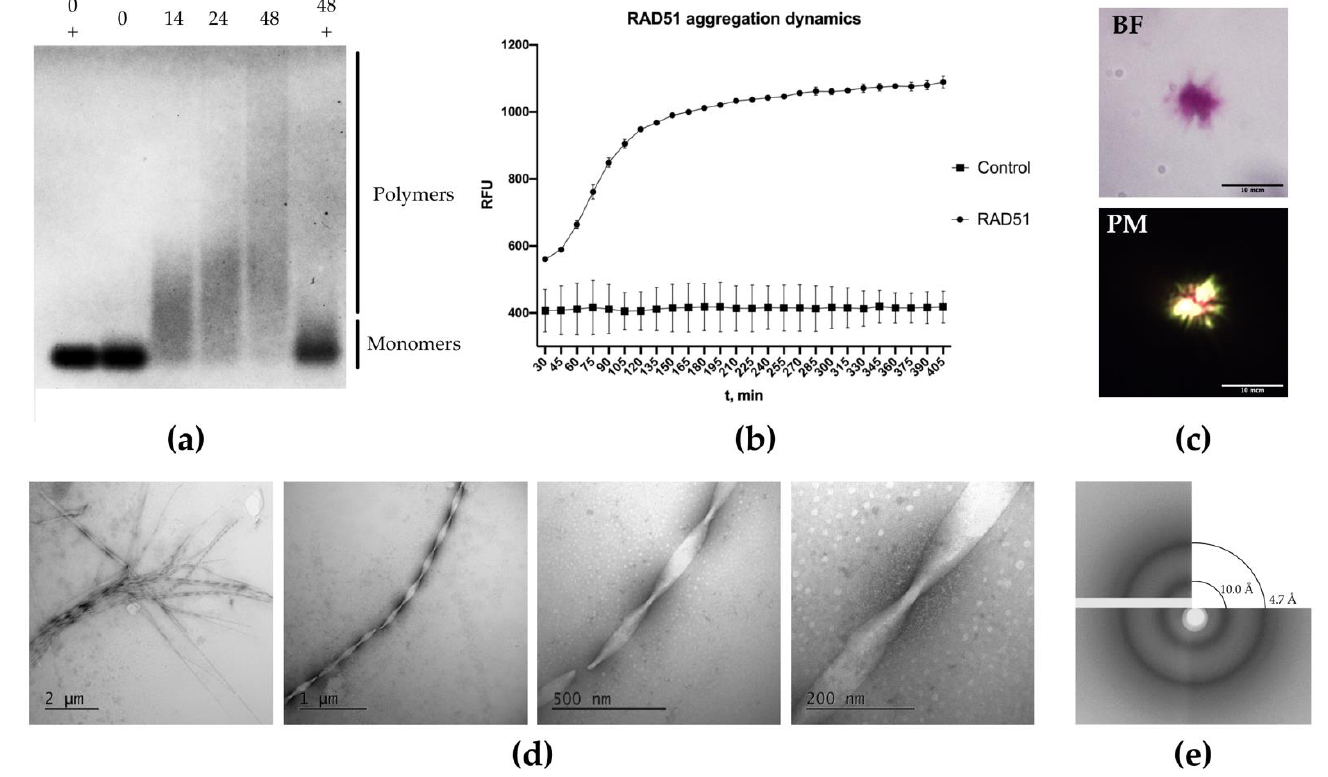
Figure 1. Analysis of RAD51 aggregation in vitro . ( a ) RAD51 forms SDS-resistant aggregates in vitro and its aggregation increases over time. SDD-AGE of RAD51 monomers and aggregates: Agarose 1%/0.1% SDS gel is presented. Numbers above the gel (0, 14, 24, 48) correspond to the incubation time (hours) , “+” reflects samples that were boiled before loading on the gel, and all samples were treated with 1% SDS prior to loading on the gel. The gel was stained as described in MM, and monomers and polymers are indicated. ( b ) Aggregation dynamics of RAD51 monomers in the presence of ThT. RFU — relative fluorescence unit; t, min — incubation time (minutes). ( c ) RAD51 aggregates bind to Congo red and show purple staining and are birefringent in polarized light. BF — bright field, PM — polarized light. ( d ) Structure of RAD51 fibrils analyzed by TEM. The samples were prepared as described in MM. ( e ) X-ray diffraction of RAD51 aggregates formed in vitro , which exhibit reflections at ~4.7 Å and ~10 Å that can be ascribed to their amyloid cross- β sheet structure.